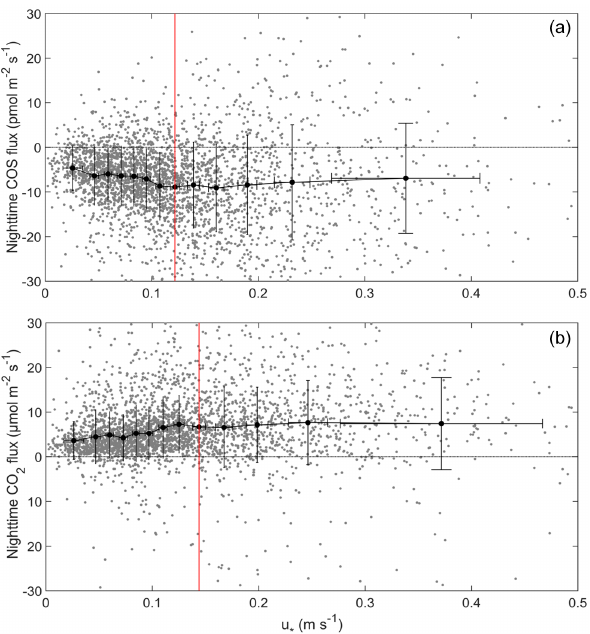
Figure 6. Nocturnal COS (a) and CO 2 (b) fluxes (inclusive of the storage term) as a function of friction velocity ( u ∗ ) . The flux data, calculated with a recursive filter (RF) using a time constant of 50s, were divided into 13 bins. The u ∗ threshold (vertical red line) was determined on the basis of the change point detection algorithm by Barr et al.